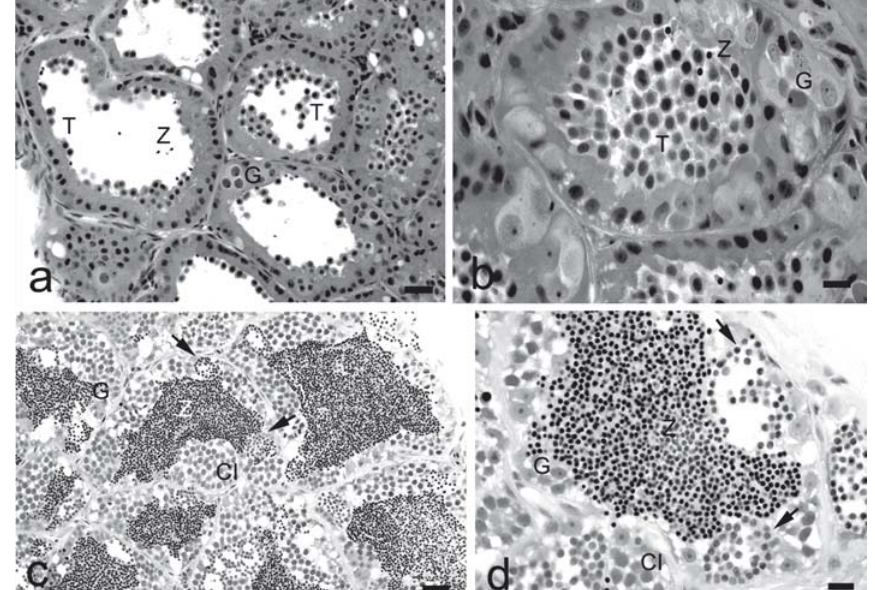
Fig. 1. Photomicrography showing a general view of the semi-cystic spermatogenesis in Corydoras flaveolus , Corydoradinae (a and b) and of the cystic spermatogenesis in Hoplosternum littorale, Callichthyinae (c and d). Scale bar a and c = 20 µm, b and d = 10 µm. CI: cysts of primary spermatocytes; G: spermatogonia; T: spermatids in the lumen of germinative compartment; Z spermatozoa, Arrow: spermatids